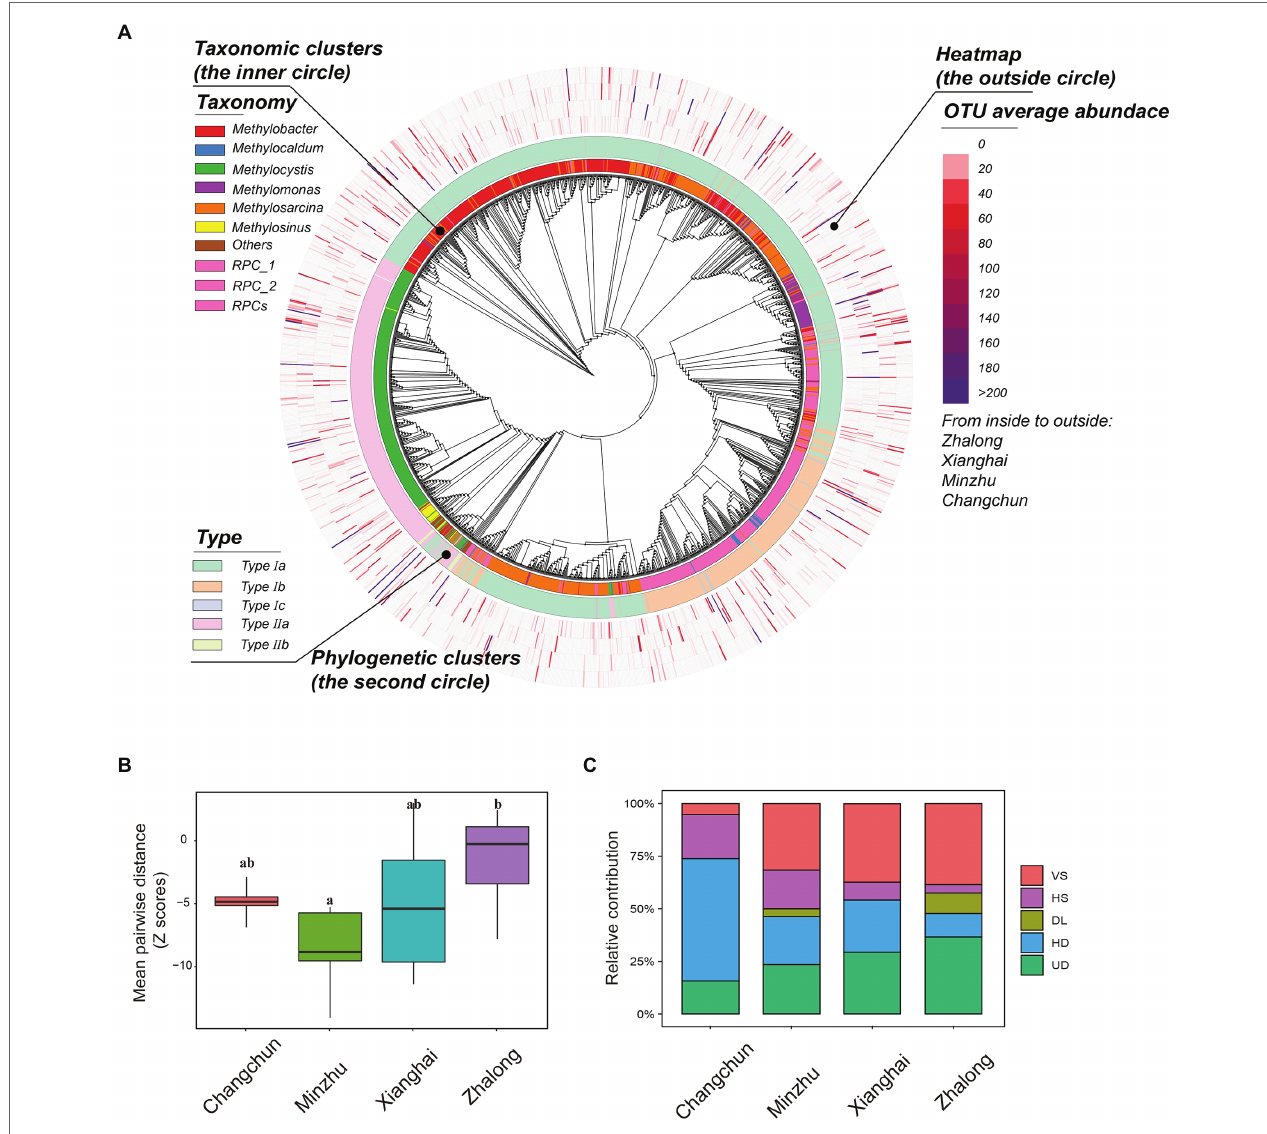
FIGURE 6 | (A) Phylogenetic tree displaying the taxonomic information, phylogenetic clusters, and OTU average abundance from inside layer to the outside layer of active methanotrophic phylotypes in four wetland soils. (B) The standardized difference of mean pairwise distance for active methanotrophic communities in four wetland soils using standard deviation (Z-score). Boxes with different lowercase letters represent significant differences ( p < 0.05). (C) The contributions of different assembly processes of active methanotrophic communities in four wetland soils. The five processes indicated the relative importance in dominating the community dissimilarity between two samples. VS, variable selection; HS, homogeneous selection; DL, dispersal limitation; HD, homogenizing dispersal; UD,